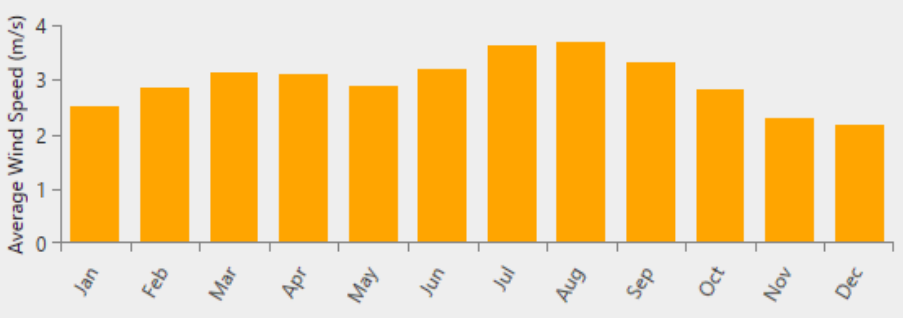
Figure 4. Irele monthly average wind speed.